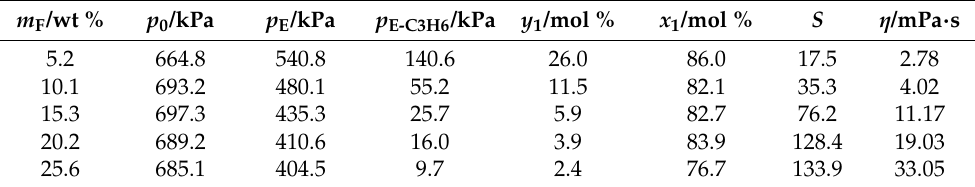
Table 2. Separation results for a C 3 H 6 (1) + H 2 (2) gas mixture ( z 1 = 0.35) using ZIF-8/water-glycol slurries where the mass ratio between water and glycol in the solution was specified to 4:1 with five different ZIF-8 mass fractions at 293.15 K and at nearly the same initial pressure ( p 0 ) of approximately 680 kPa. S represents the apparent selectivity of C 3 H 6 over H 2 in a given slurry. η represents the viscosity of the slurries corresponding to different ZIF-8 mass fractions at 293.15 K.